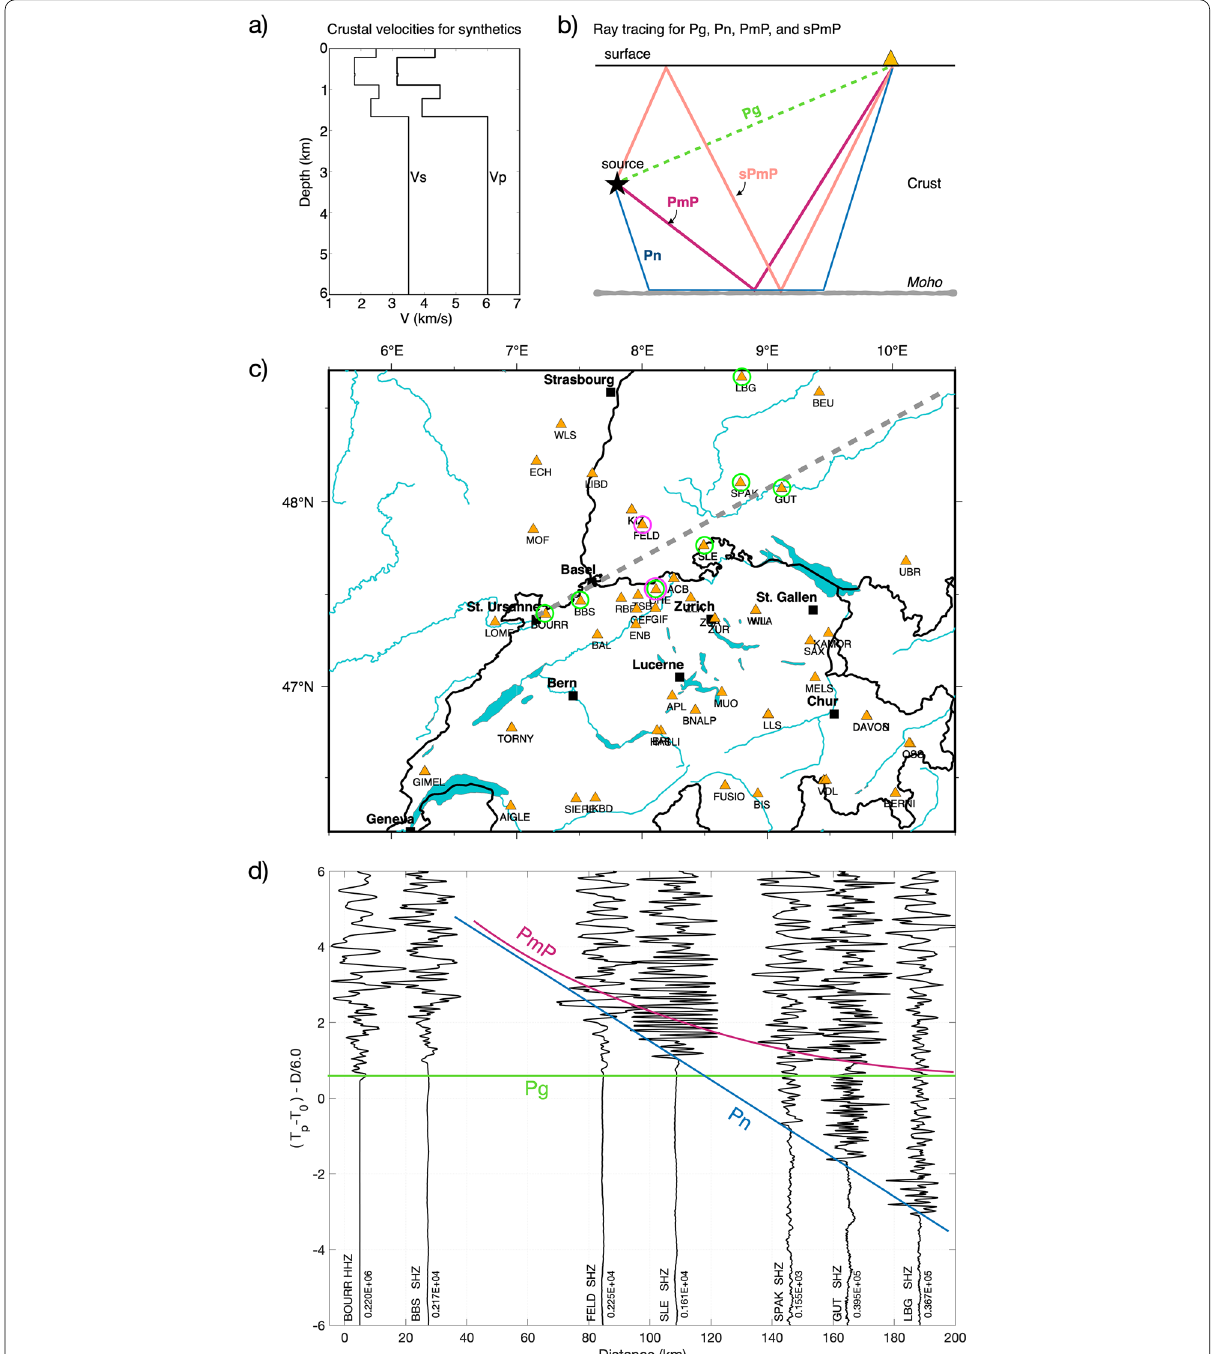
Fig. 6 a P-wave and S-wave velocities of the sedimentary cover around Saint-Ursanne estimated from NAGRA borehole logs in NE Switzerland. The average velocity is 4.2 km/s. b Diagram of Pg, Pn, PmP, and sPmP rays travelling through the crust from the hypocenter (star) to the station (triangle). c Recording stations during the 2000 sequence. Dashed line indicates the profile used in the calculation for the synthetic modelling. Stations shown in Fig. 7 are circled in magenta, whereas green circles indicate the stations shown in d). d) Reduced travel times (Vred of epicentral distance (D) along the profile in the NE direction shown in ( c ) for real data from the main shock of the Saint-Ursanne sequence (M L 3.2 event of 2000/04/06 00:46:6.0). Arrivals along the green horizontal line have an apparent velocity of 6.0 km/s and have travelled through the upper crust (Pg). The arrivals along oblique lines beyond about 120 km are Pn arrivals, indicating arrivals refracted at the Moho. Note the relatively emergent Pg-onsets at the first three stations compared to the relatively strong and impulsive Pn-onsets beyond 140